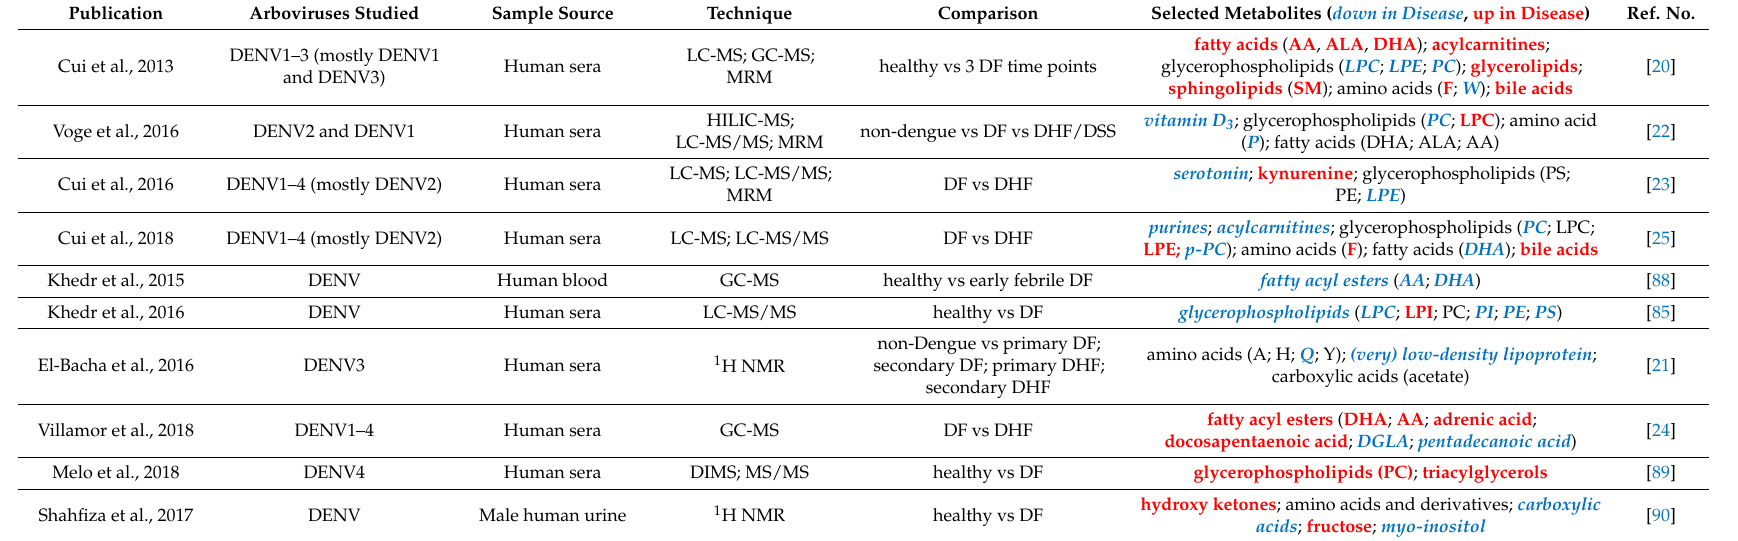
Table 2. Selected metabolites from publications on human infections with dengue viruses (DENVs). Metabolites generally increased in disease are in red, decreased metabolites are in blue. Black metabolites have mixed results in the corresponding publication. If not specified, LC was reversed-phase. Standard single letter amino acid abbreviations are